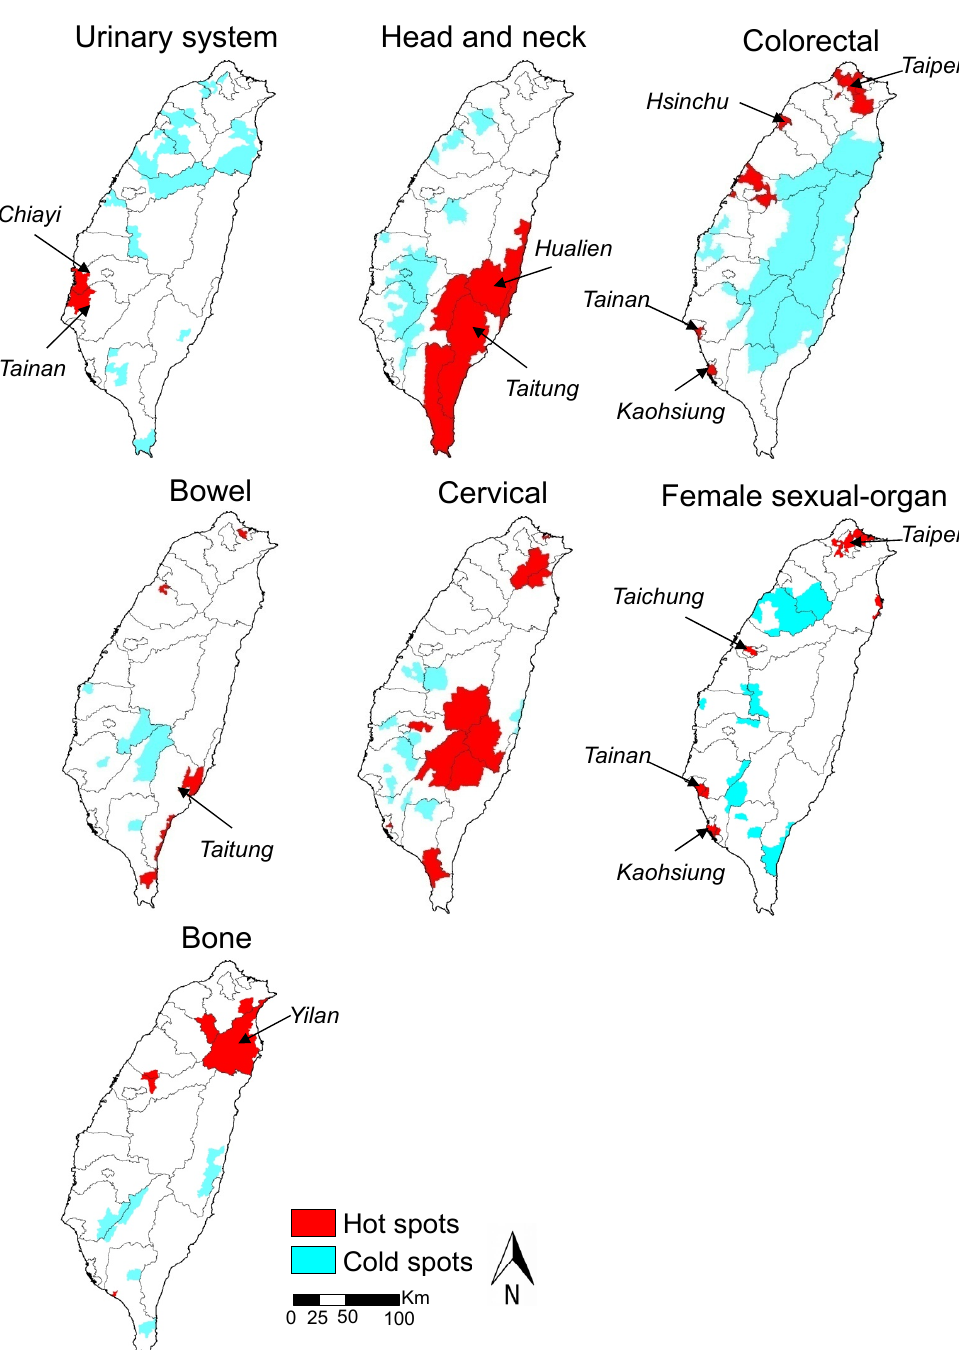
Figure 2. The locations of statistically significant hot spots and cold spots of major female cancer